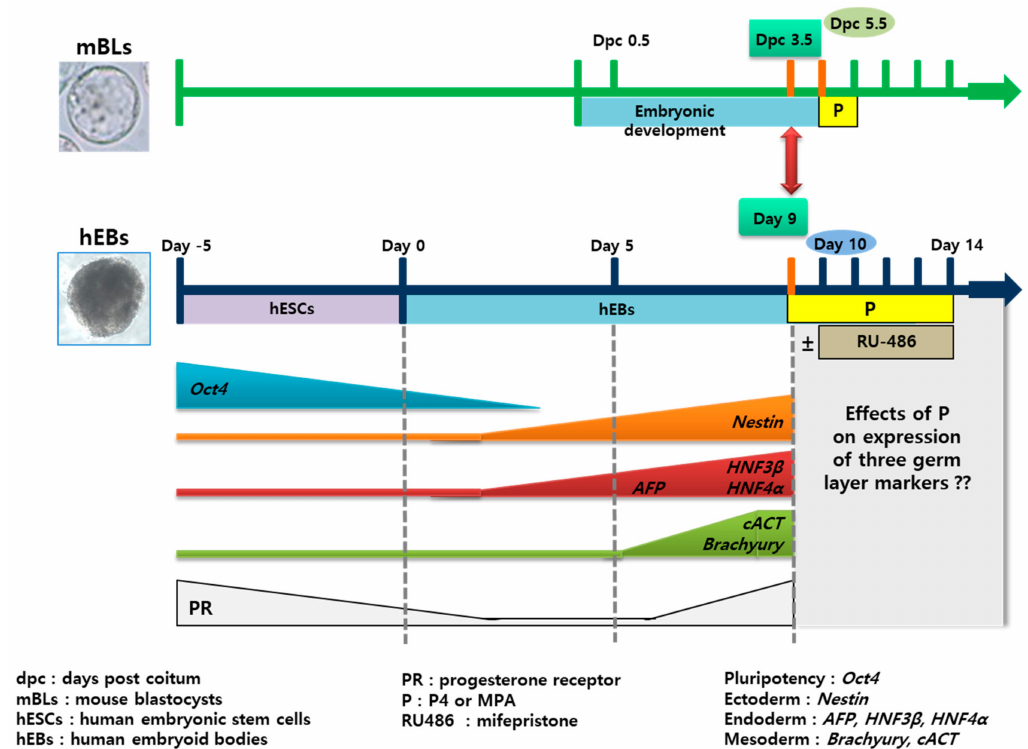
Figure 1. Schematic presentation representing the experiments using human embryoid bodies (hEBs) and mouse embryos. hEBs were formed from human embryonic stem cells (hESCs) using suspension culture. hEBs cultured for 9 days were treated with progesterone (P 4 ) or medroxyprogesterone acetate (MPA) at 10 − 8 M, 10 − 7 M, 10 − 6 M, and 10 − 5 M for 5 days. RU486 was treated for 4 days to check if the post-treatment changes in the expression of three germ layer marker genes were P 4 or MPA-specific. Mouse blastocysts (mBLs) were treated with P 4 or MPA at 10 − 7 M for 24 h, and the expression of three germ layer marker genes was assessed. The expression level of pluripotency, ectoderm, endoderm, and mesoderm-specific genes and of progesterone receptor (PR) gene is